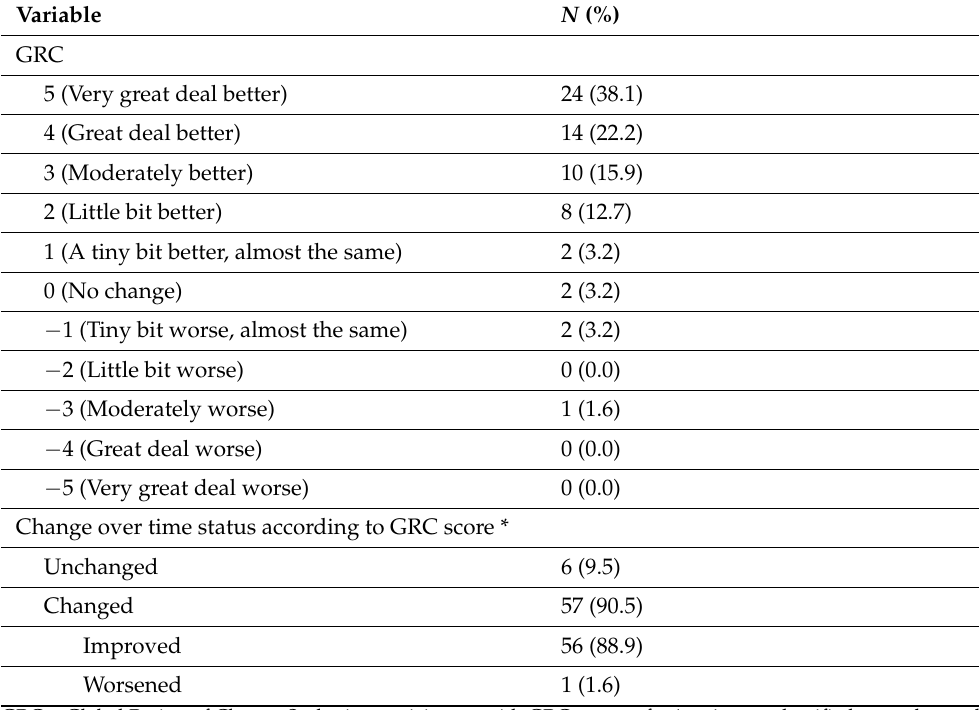
Table 3. Participants according to their global rating of change score at follow-up ( N =